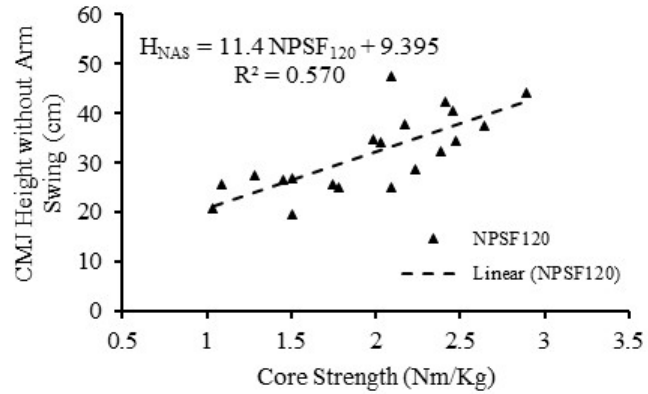
Figure 5. Results of regression analysis of CMJ height without arm-swing (H NAS ) with 12 core strength measurements (n = 20) are the same as in Figure 4.